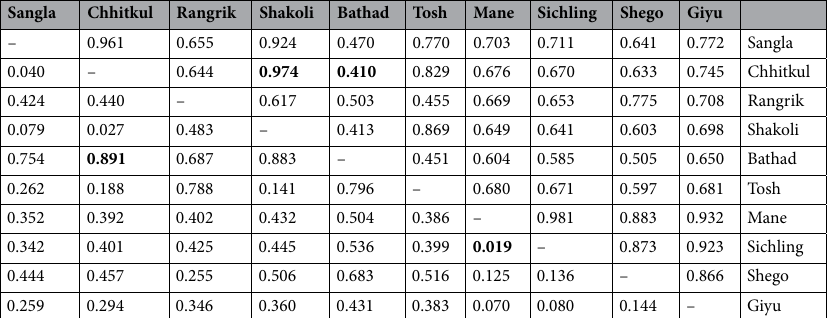
Table 4. Nei’s genetic distance represented below diagonal and Nei’s genetic identity values represented above diagonal are given for 10 populations of Dactylorhiza hatagirea . Bold character indicates the highest value, and the lowest